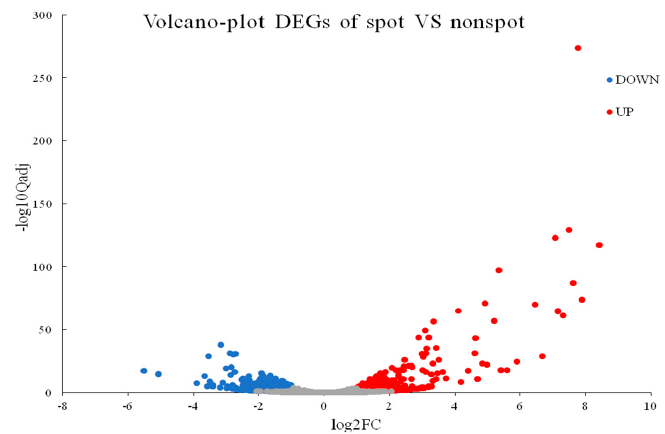
Figure 2. Volcano plot of differentially expressed genes (DEGs). X axis: log2 transformed fold change; Y axis: − log10 transformed significance; Red points: upregulated DEGs; Blue points: downregulated DEGs. Gray points: non-DEGs.